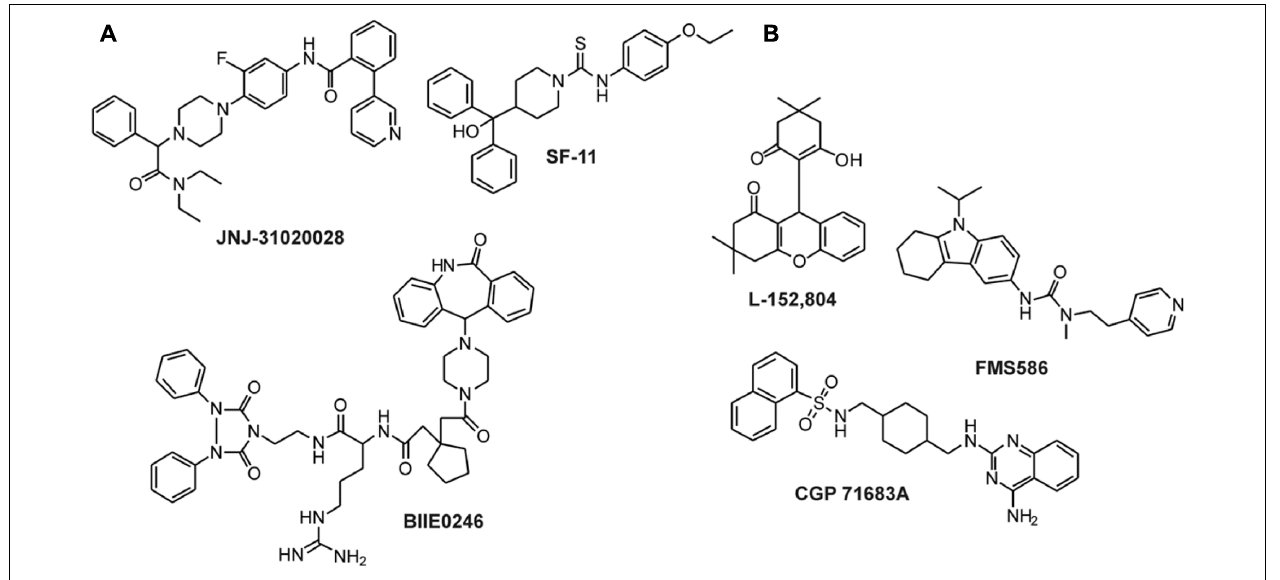
FIGURE 5 | Non-peptidic antagonists ofY 2 andY 5 receptors. (A) Y 2 receptor antagonists (Doods etal., 1999; Saldanha etal., 2009; Shoblock etal., 2010; Swanson etal., 2011); (B) Y 5 receptor antagonists (Criscione etal., 1998; Kanatani etal., 2000a; Rueeger etal., 2000; Kakui etal., 2006).